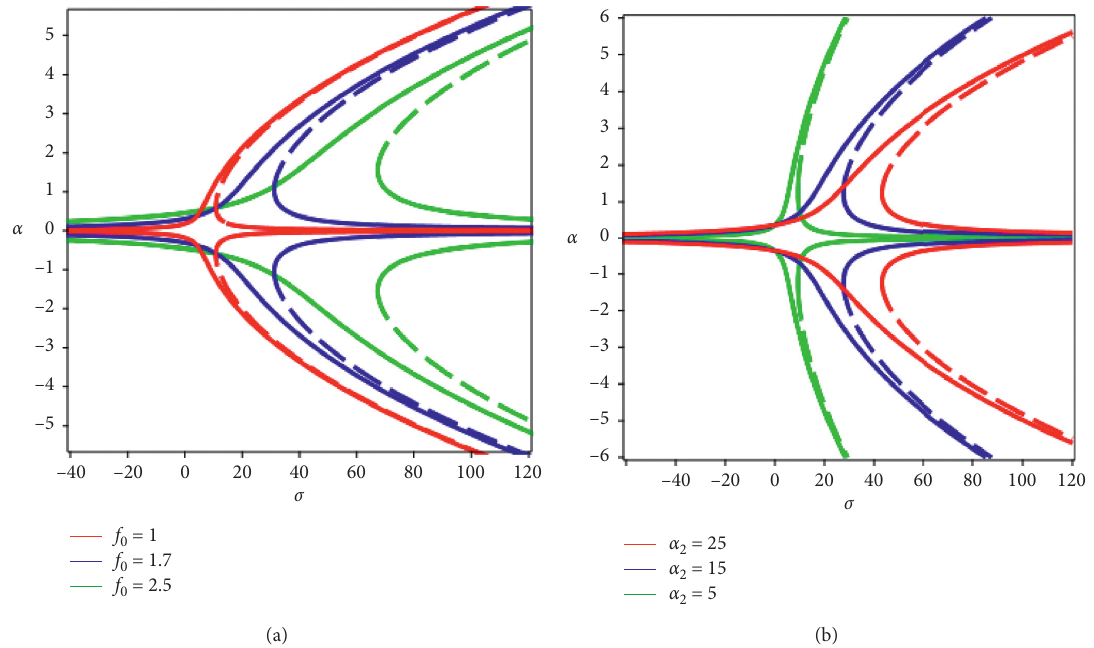
Figure 8: Frequency response for the third-order subharmonic resonance. (a) Ω ≈ 1/3, α � 2. Solid and broken lines are used for the loci of stable and unstable responses, and f 0